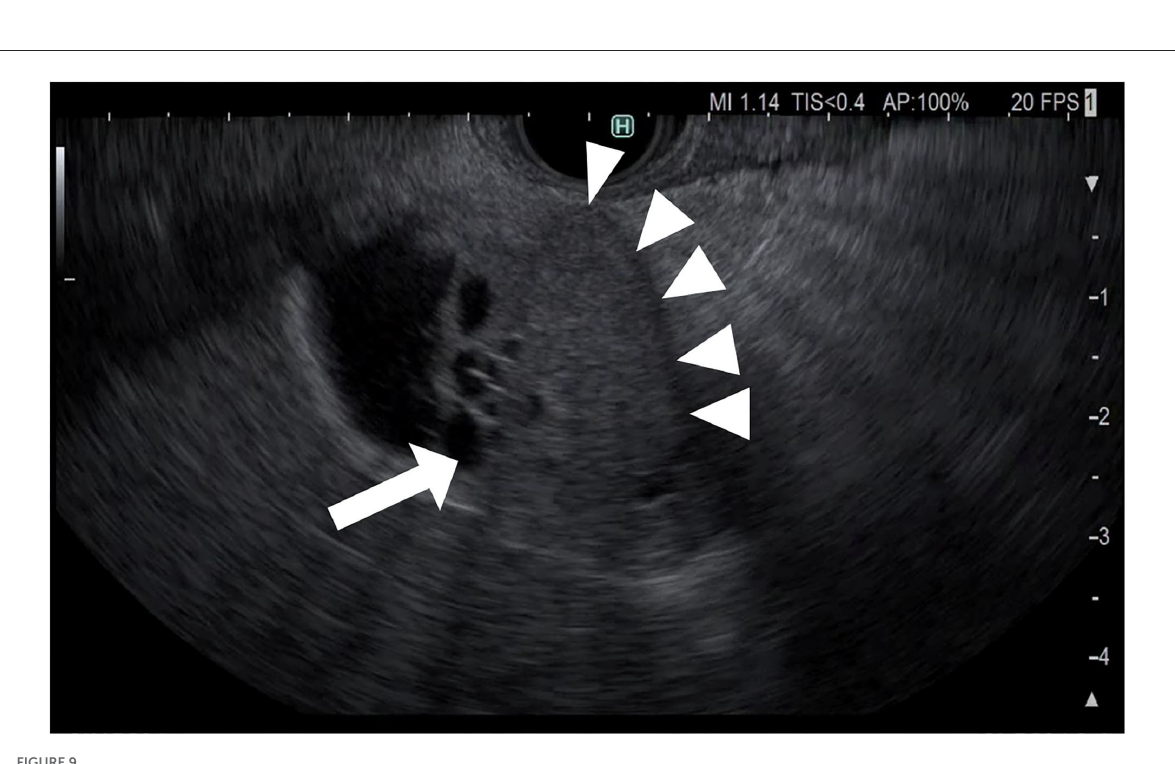
FIGURE9 Fundamental B-mode EUS for staging of gallbladder carcinoma. T4 gallbladder carcinoma: heterogeneous hypoechoic tumor (arrow) in the gallbladder without a disrupted hyperechoic layer